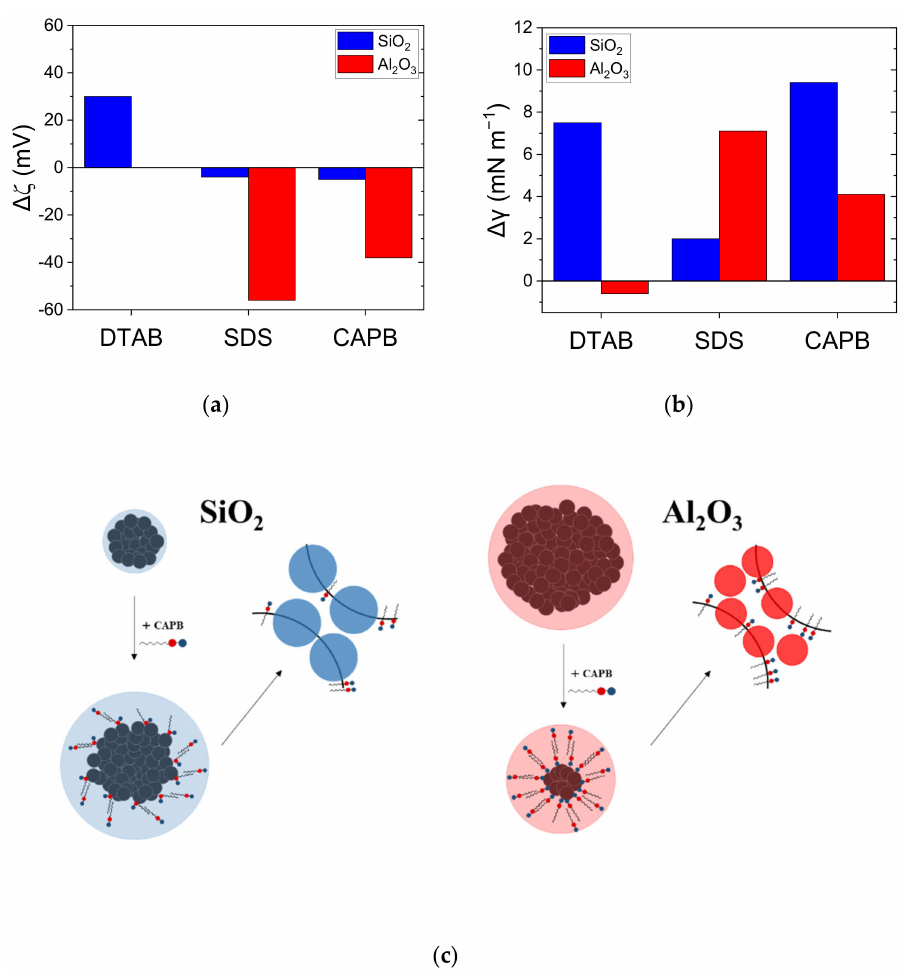
Figure 4. Changes in ( a ) ζ -potential of NPs in the presence of surfactants, and in ( b ) surface tension ( γ ) of the surfactant in the presence of NPs (formulations in desulphated seawater brine, at 25 ◦ C). ( c ) Schematics illustrating the effect of the zwitterionic surfactant (CAPB) on NP dispersion in brine and adsorption at the gas–solution